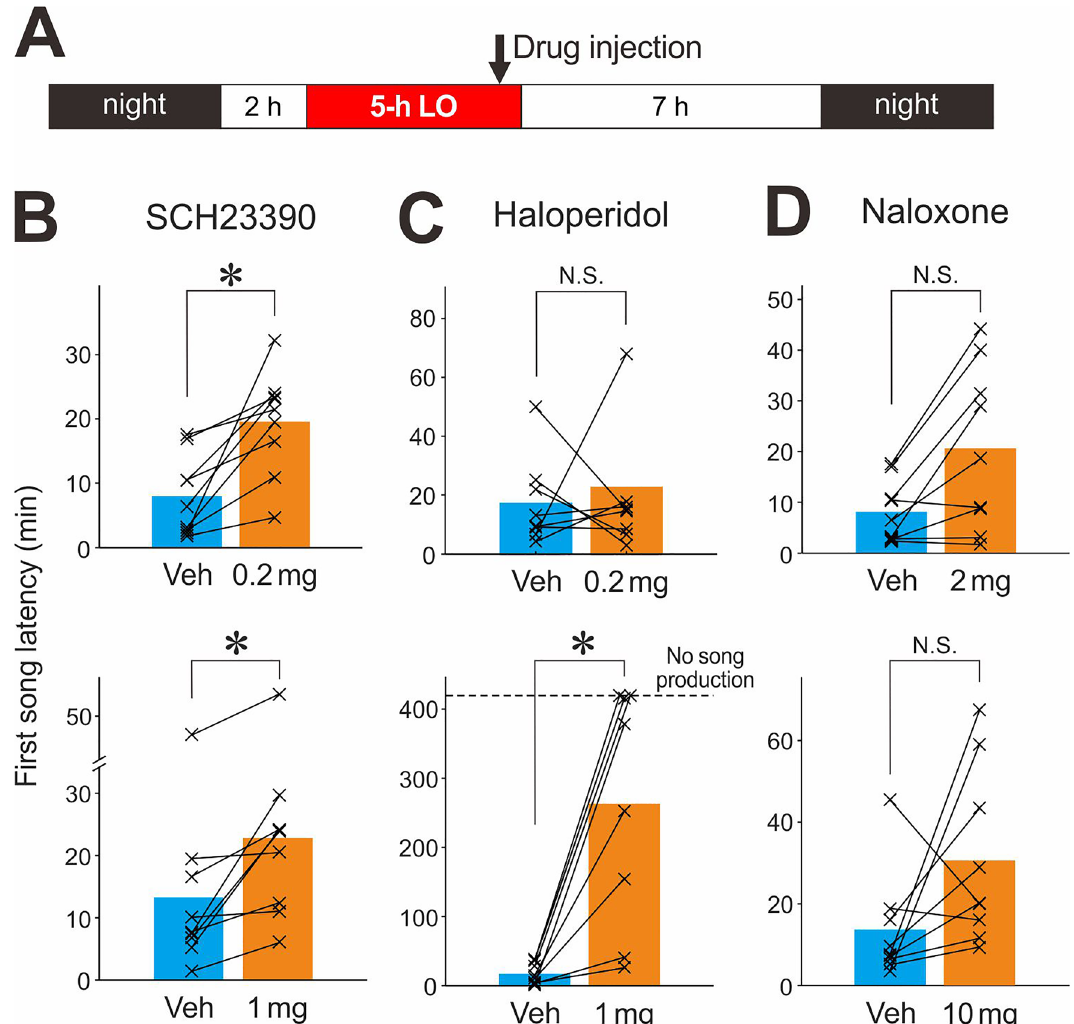
Figure 5. Effects of systemic injections of dopamine or opioid antagonists on first song latencies after 5-h LO in young adult birds. ( A ) Schedules of drug injections. Drugs or their vehicles were injected at 30-min preceding the offset of 5-h LO periods. ( B ) Comparisons of first song latencies between a dopamine D1 receptor antagonist SCH23390 with lower (0.2 mg/kg, top ) and higher (1 mg/kg, bottom ) doses and its vehicle (‘Veh’). Each line indicates a single bird. Injections of both lower and higher doses significantly increased first song latencies compared to the vehicle (* p = 0.004, significance level α was corrected to 0.0083 with a Holm- Bonferroni correction for multiple comparisons). ( C ) Comparisons between a dopamine D2 receptor antagonist haloperidol with lower (0.2 mg/kg, top ) and higher (1 mg/kg, bottom ) doses and its vehicle. Injections of the higher dose, but not the lower dose, greatly prolonged the first song latencies (* p = 0.008, corrected α = 0.0125). If no song production was observed during the post-LO period (7-h duration), the data was assigned a time of 7 h (420 min, dashed line). ( D ) Comparisons between an opioid antagonist naloxone with lower (2 mg/kg, top ) and higher (10 mg/kg, bottom ) doses and its vehicle. The effects of naloxone were not significant for either dose ( p = 0.04 and corrected α = 0.0167 for lower dose; p = 0.07 and corrected α = 0.025 for higher